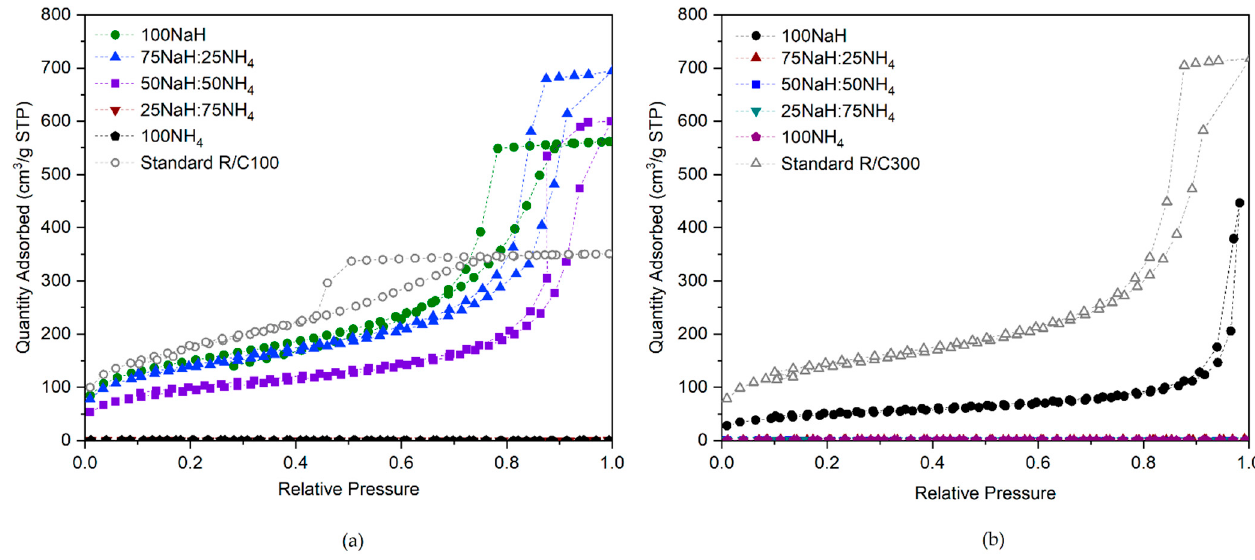
Figure 5. Isotherms for ( a ) sample set 2(i) NaH/NH 4 R/C100 HCO 3 − equivalent, and ( b ) sample set 2(ii) NaH/NH 4 R/C300 HCO 3 − equivalent. Note that R/C is the resorcinol/catalyst molar ratio.